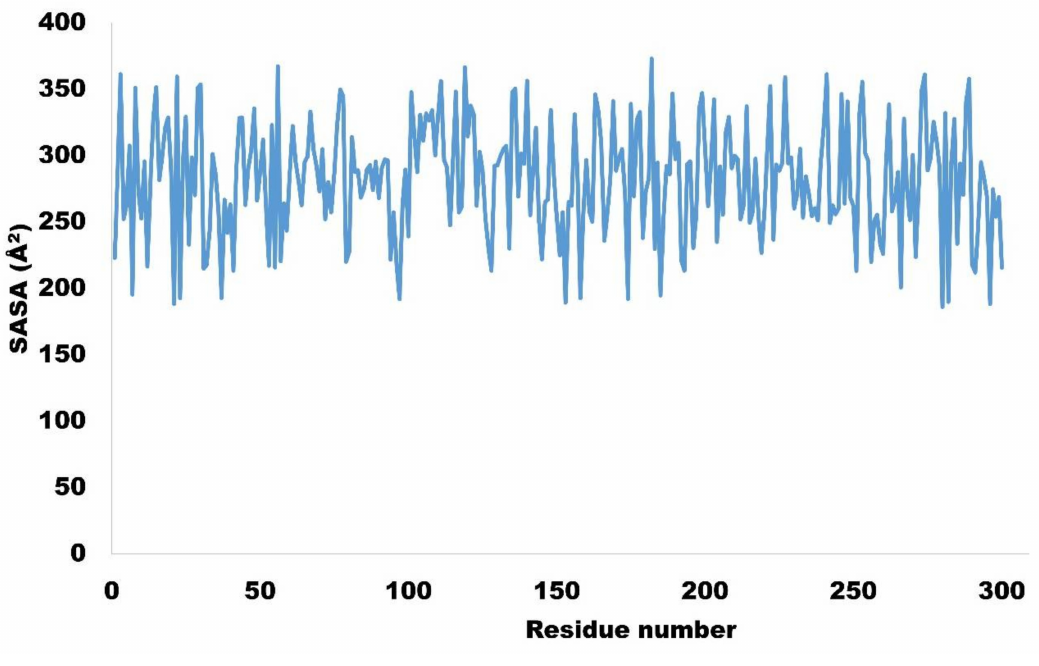
Figure 15. Residue wise solvent accessible surface area (SASA) for NEK7.